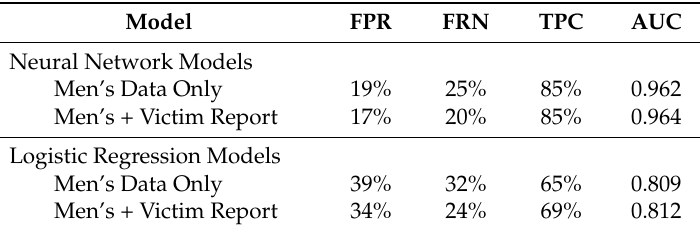
Table 3. Comparison of regression and neural network